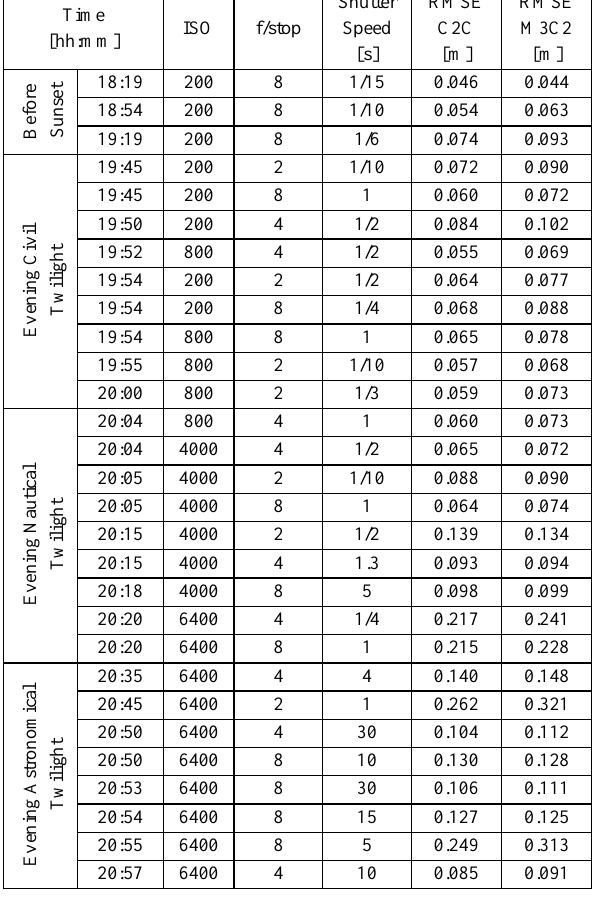
Table 3 – RMSE of the distance values for the 29 photogrammetric models computed with the C2C and M3C2 method sorted by the acquisition time of the